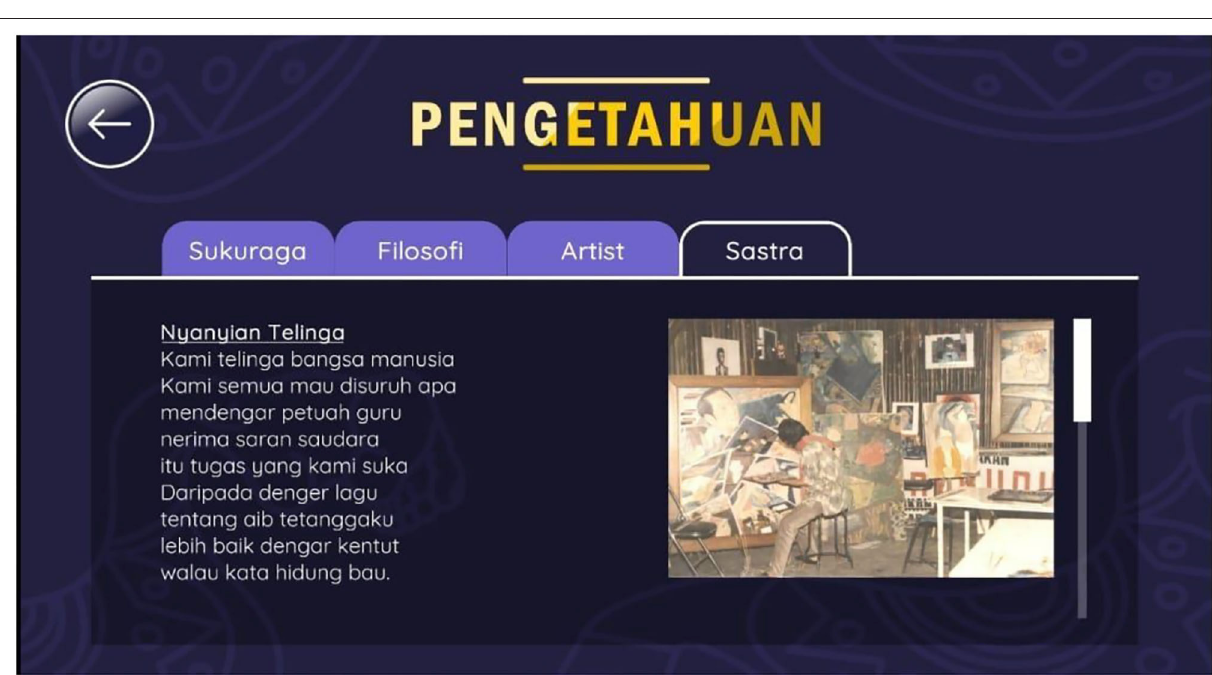
FIGURE 6 | Ear songs in the Literature feature in the Sukuraga Puppet